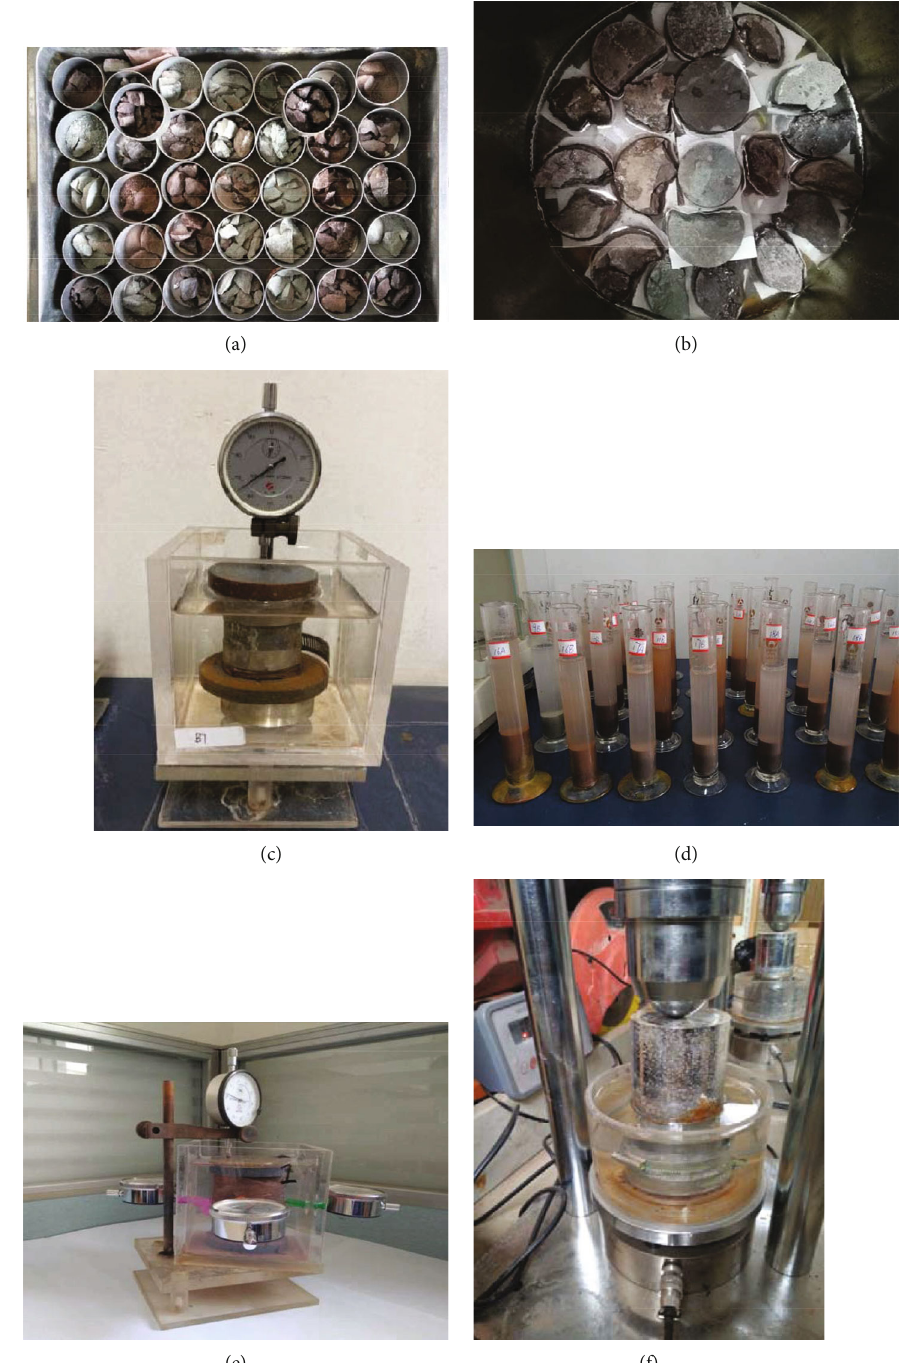
Figure 4: Laboratory basic physical and mechanical tests: (a) water content; (b) dry saturated absorbed water ratio; (c) con fi ned swelling ratio; (d) free swelling ratio of rock powder; (e) three-dimensional swelling ratio; (f) swelling